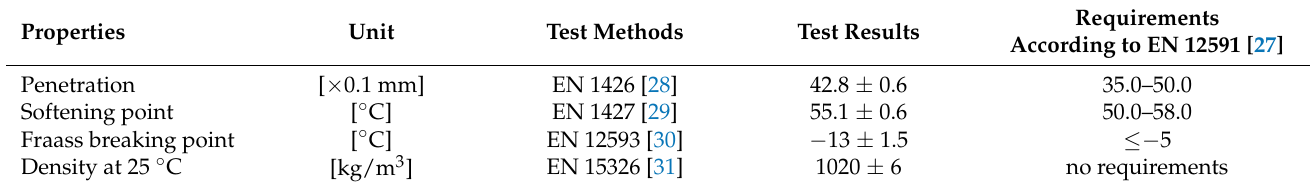
Table 1. Basic properties of the 35/50 penetration grade bitumen.